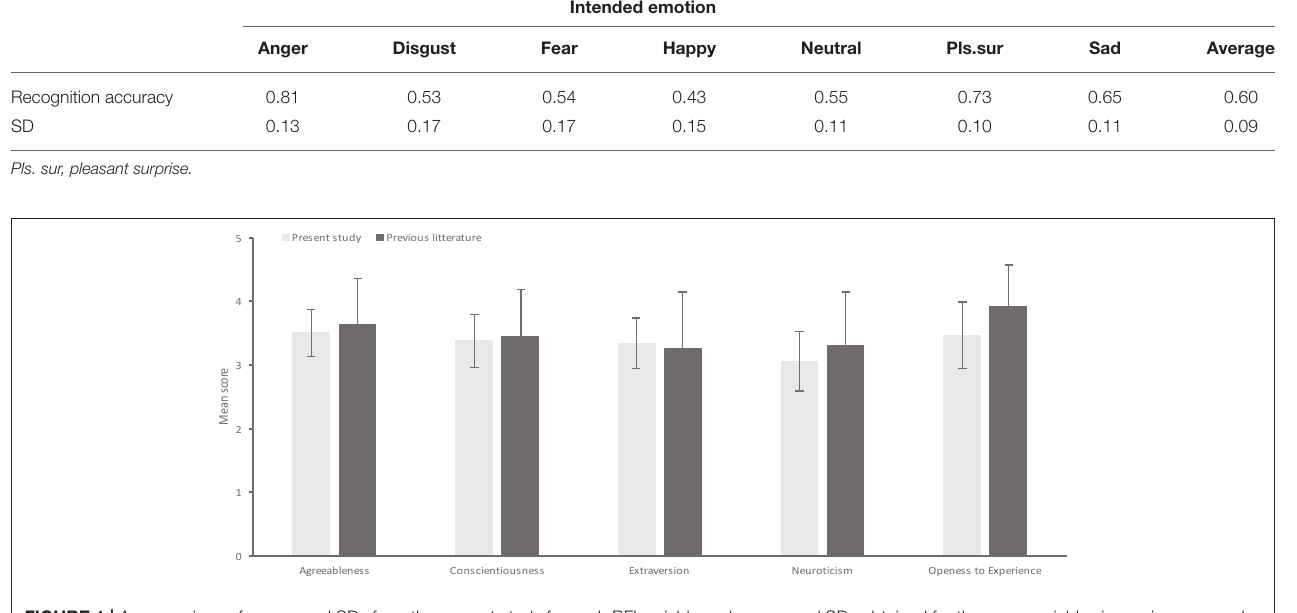
FIGURE 1 | A comparison of means and SDs from the present study for each BFI variable and means and SDs obtained for the same variables in previous research. Means from the previous literature are based on results reported by Srivastava et al. (2003), where a mean age of 20 years was used for comparison, as the mean age of the present sample was 19.5